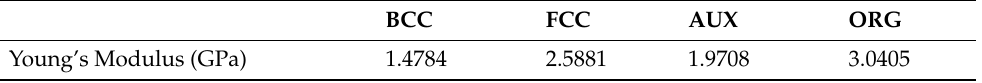
Figure 12. Elastic section of stress–strain curve from compression test results. Linear approxima- tions of elastic compression. Solid lines indicate the bulk Young’s moduli of the lattices, meeting 99% accuracy or more. Table 8. Summary of Young’s moduli for the four lattice topologies from mechanical test results. BCC